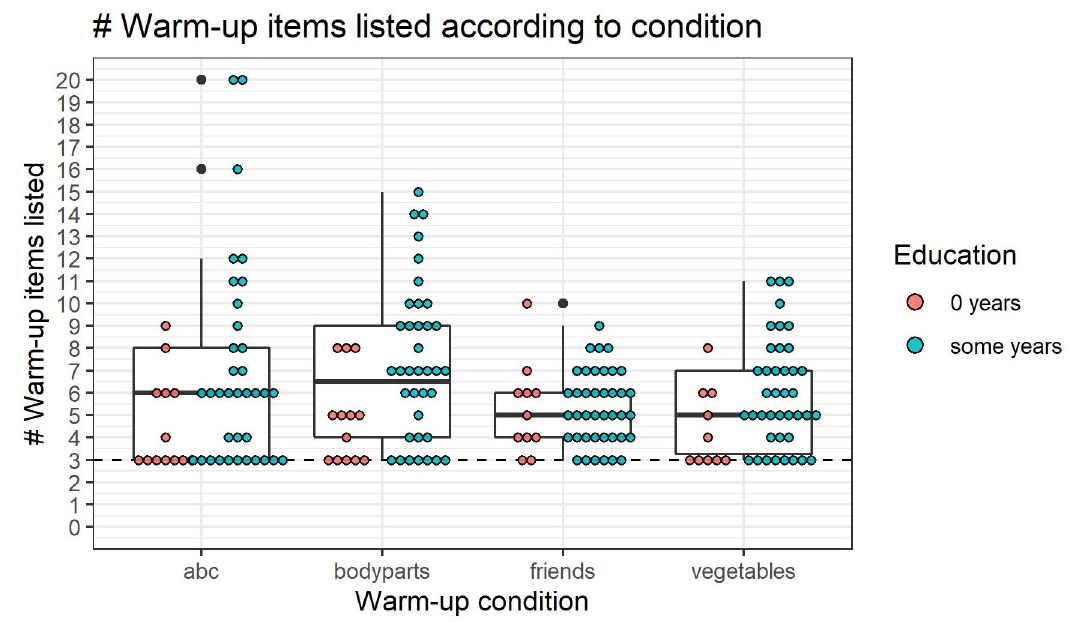
Fig 2. Warm-up items listed per warm-up condition. How many warm-up items were listed for each warm-up condition. As in the other tasks (except for Give-N), the baseline number of items named is set to y = 3 for every child, because children were given 3 example items to verbalize before being asked to continue listing items on their own. For easier visualization, children’s count list responses have been cut off at 20. Individual dots are color-coded by